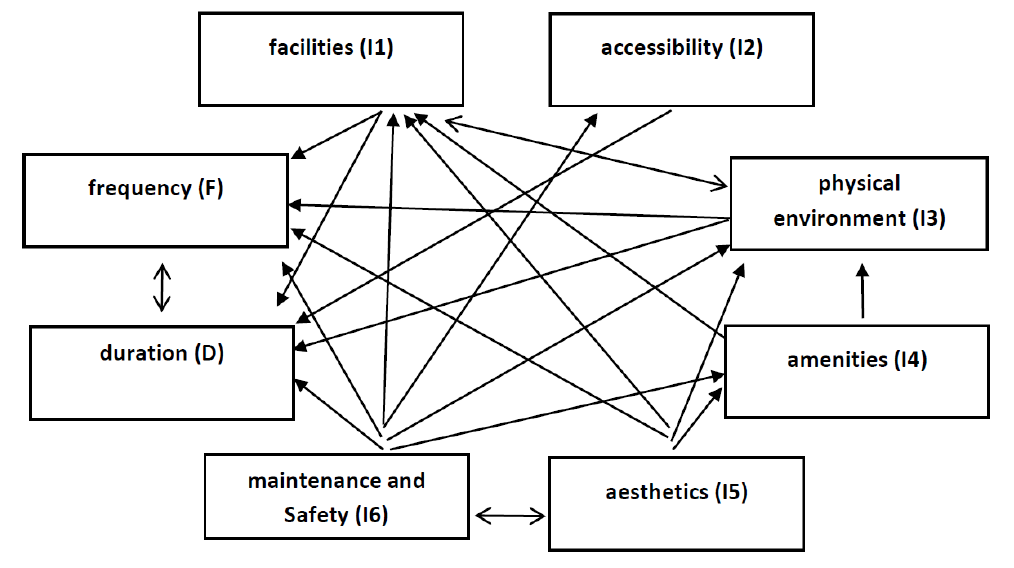
Figure 2. Relation map of factors.